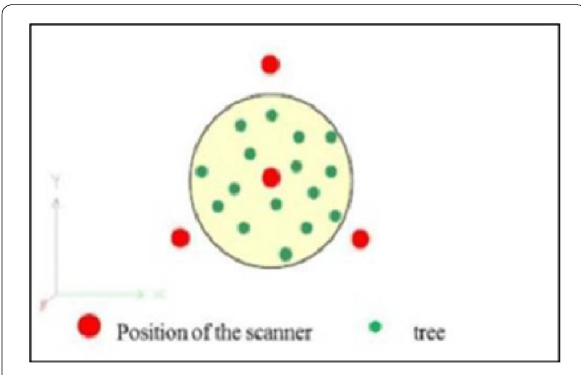
Fig. 2 TLS scan positions used for the study (Prasad et al. 2016)